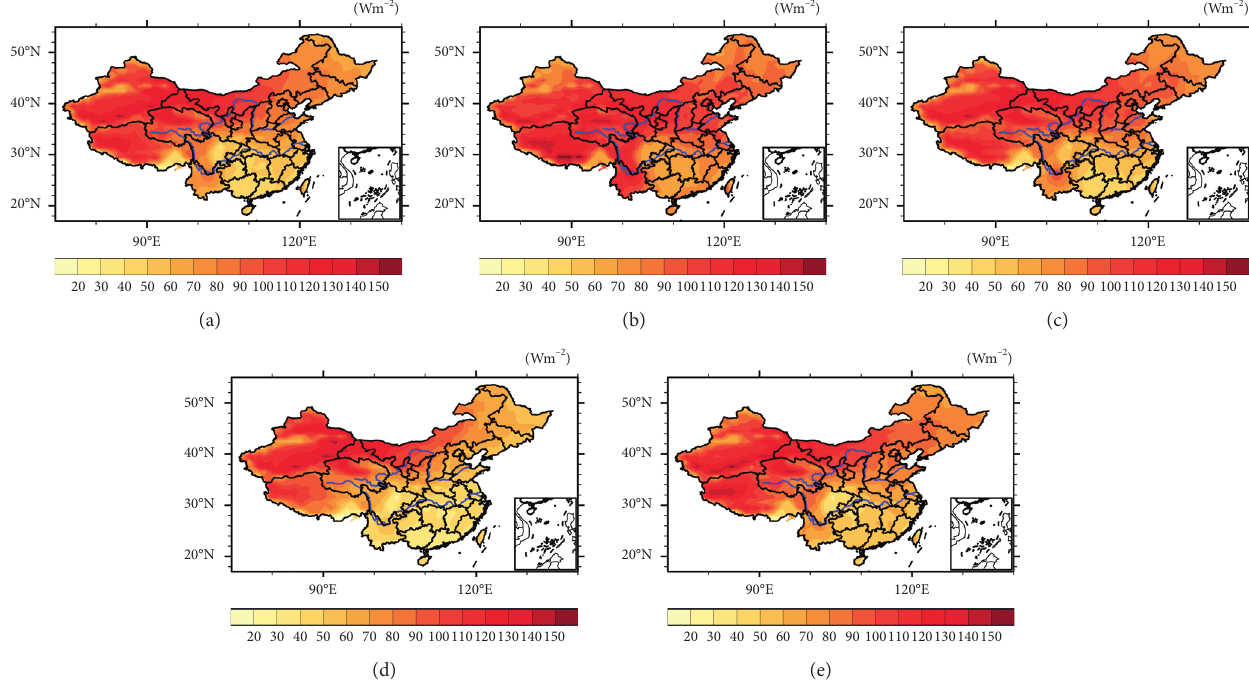
Figure 1: Distribution of annual and seasonal LER mean (unit: Wm − 2 ) in China under all-sky conditions during the period 2001–2016: (a) annual, (b) spring, (c) summer, (d) autumn, and (e) winter.